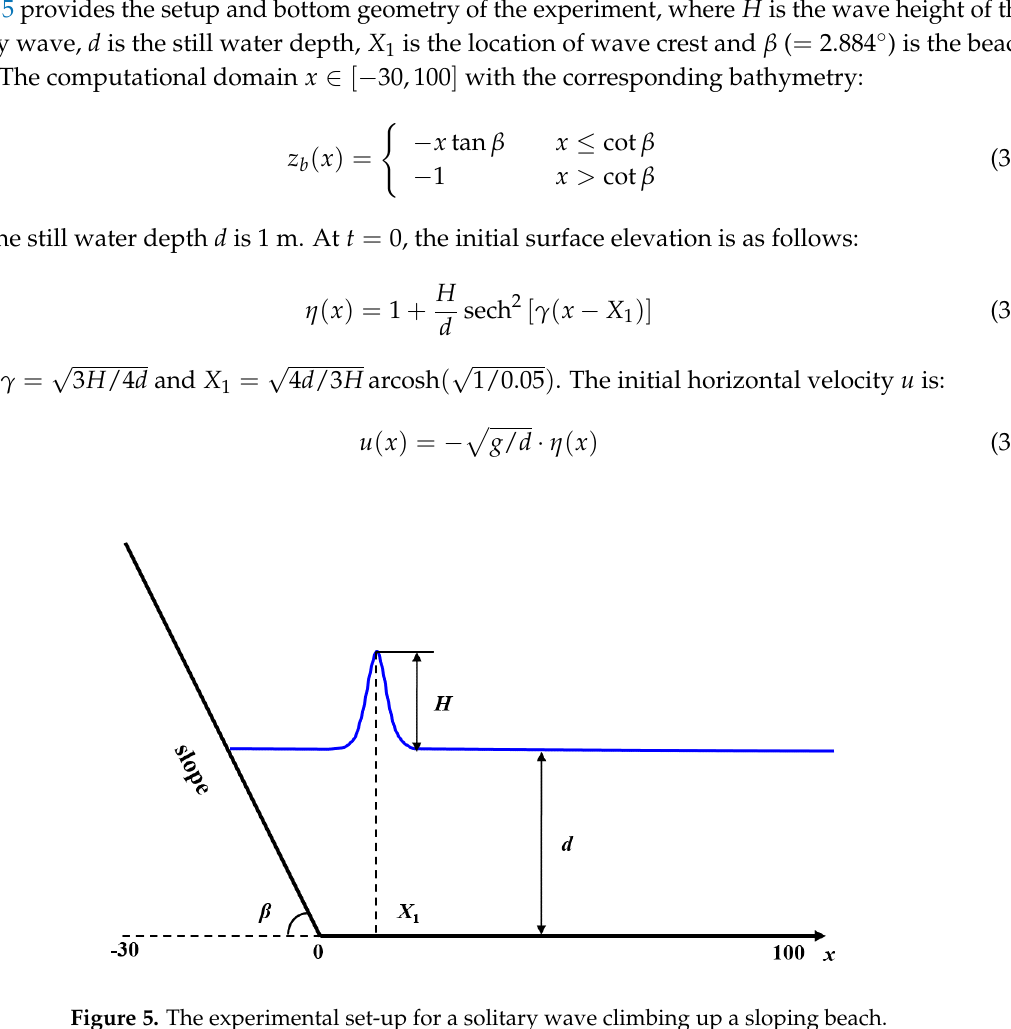
Figure 5. The experimental set-up for a solitary wave climbing up a sloping